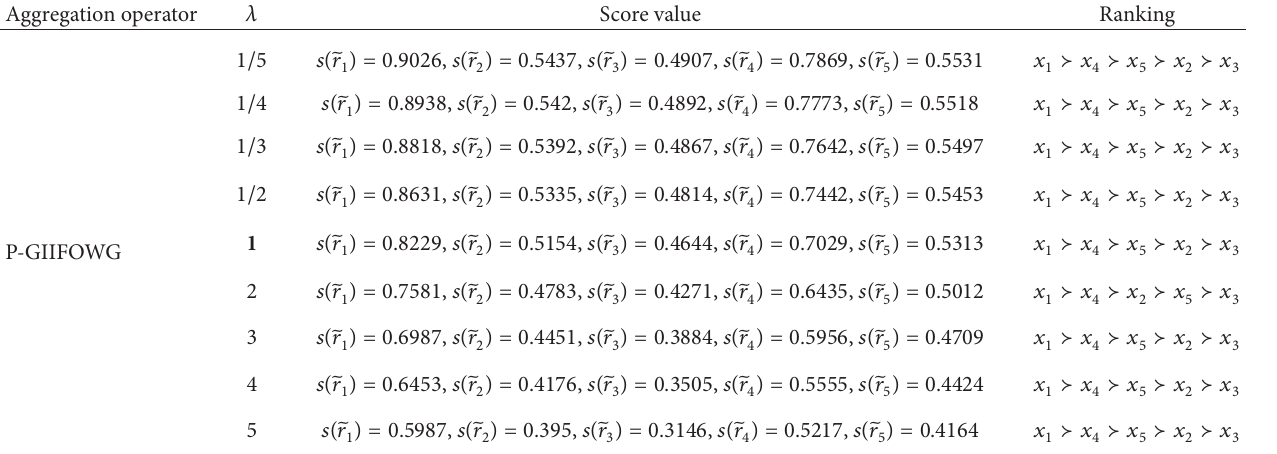
Table 13: Ranking results obtained by applying P-GIIFOWG on assessments given by 𝑑 1 . Aggregation